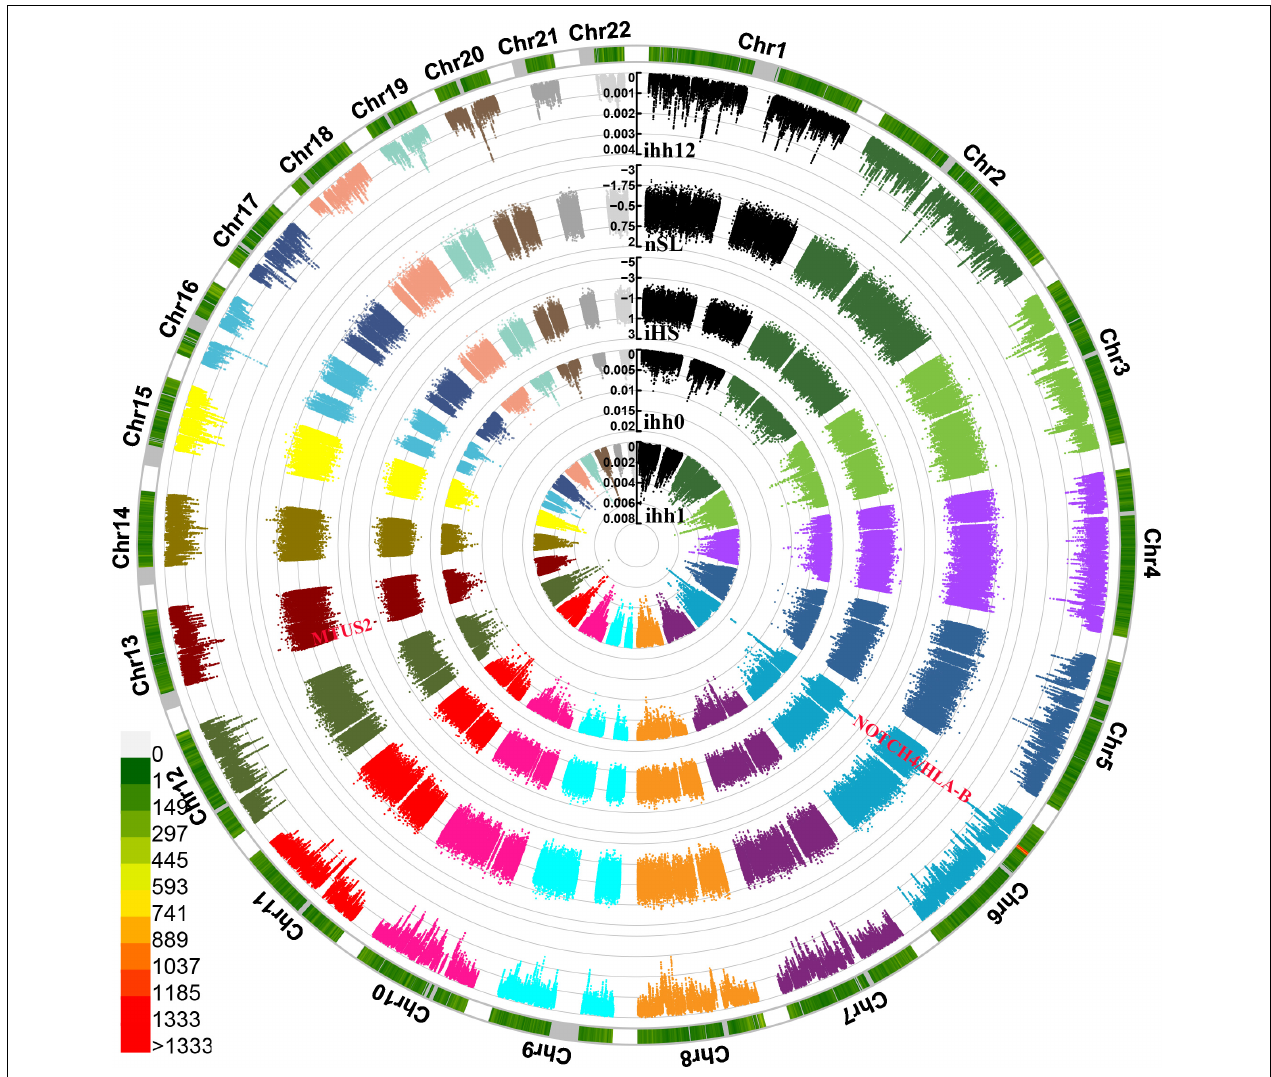
FIGURE 7 | Circle Manhattan plots showed the signatures of natural selection based on the different statistic indexes. From inside to outsides: allele frequency of ancestry allele, ihh1, ihh0, iHS, nSL, and